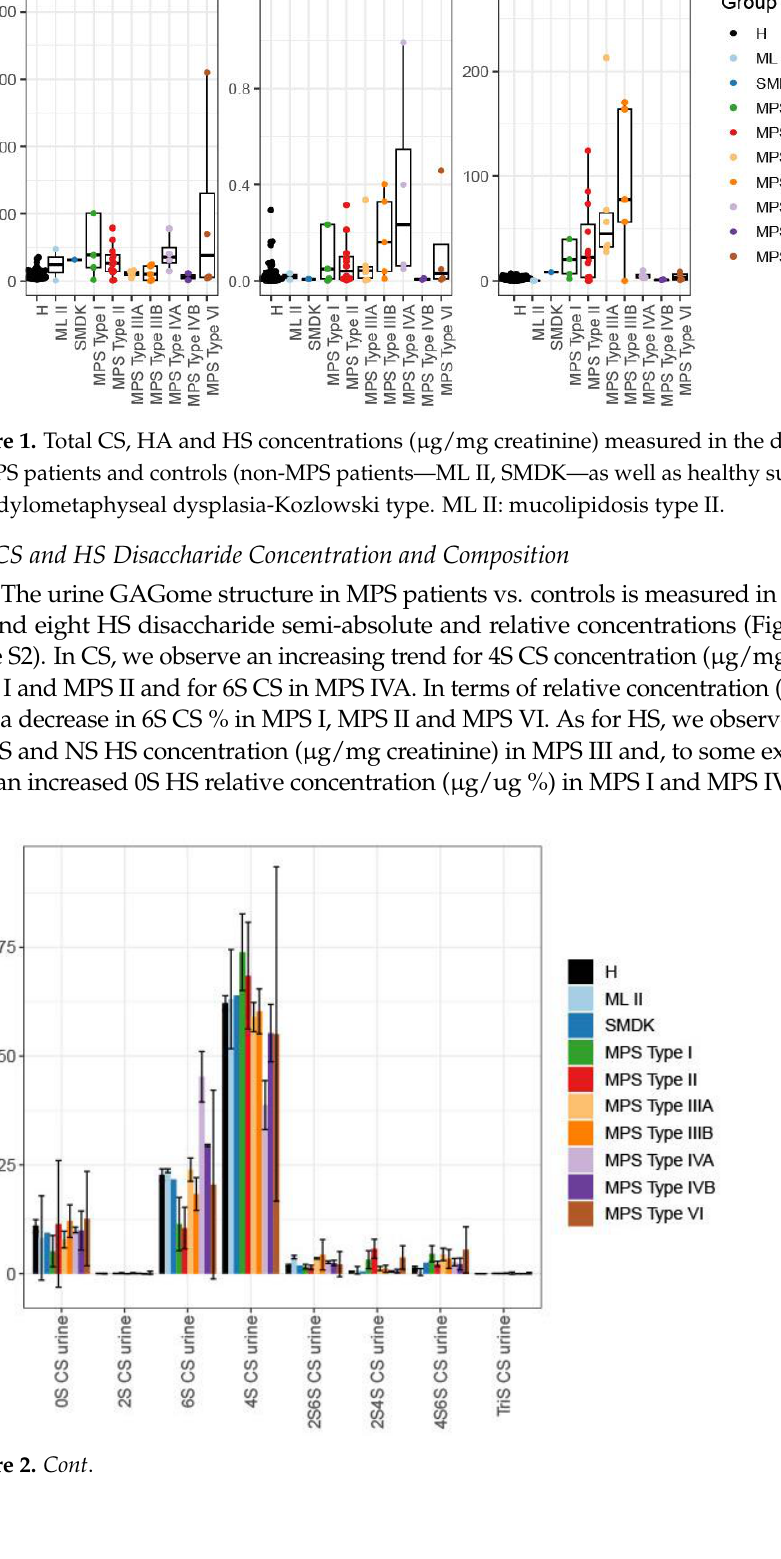
Figure 2. Relative concentration (in mass fraction %) of CS (upper panel) and HS (lower panel) di- saccharides in the groups. SMDK: spondylometaphyseal dysplasia-Kozlowski type. ML II: muco- lipidosis type II. See also Table S2.